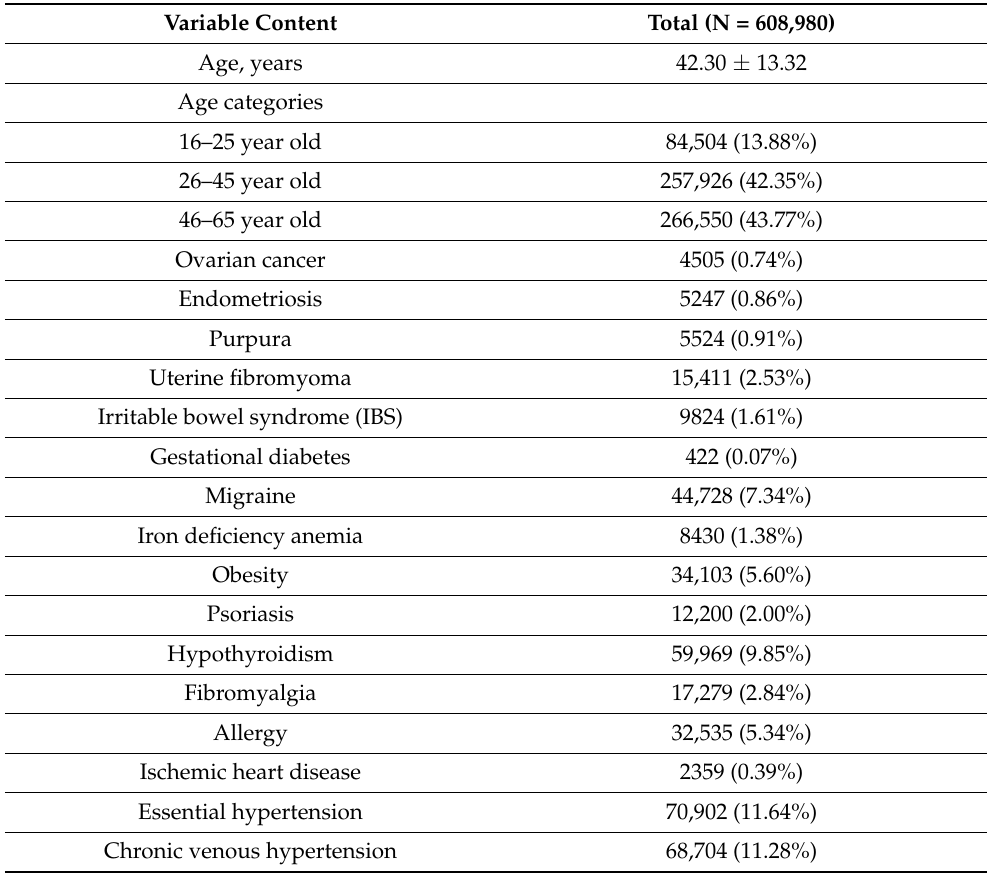
Table 1. Univariate analysis.